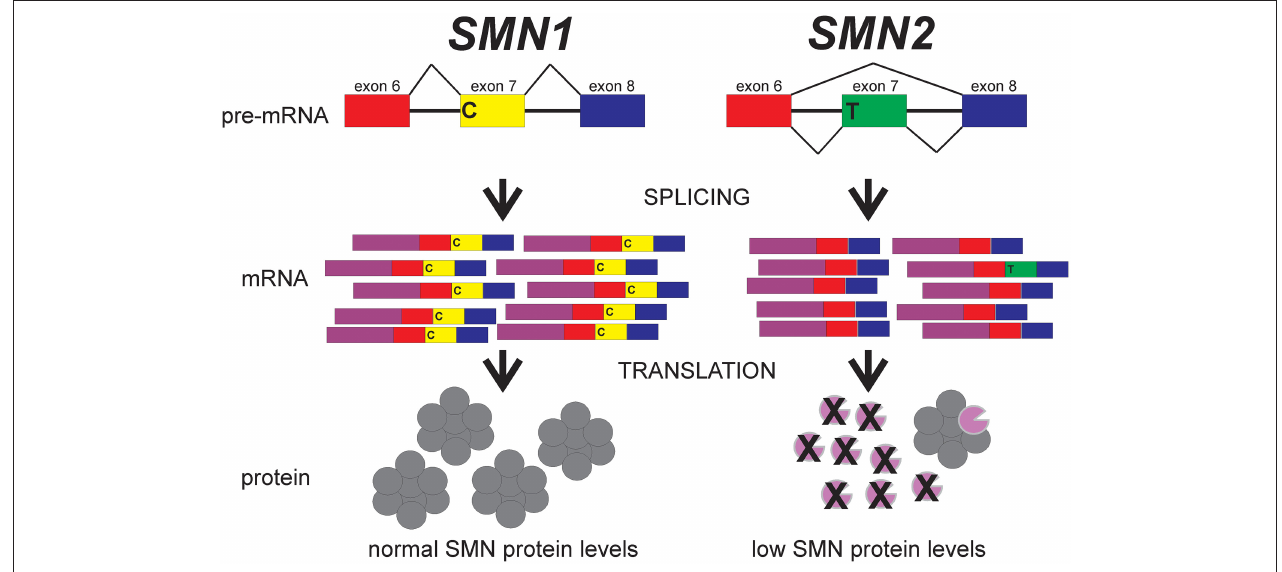
FIGURE 2 | The effect of the C-to-T transition in exon 7 between SMN1 and SMN2 on splicing. Adapted from Butchbach and Burghes